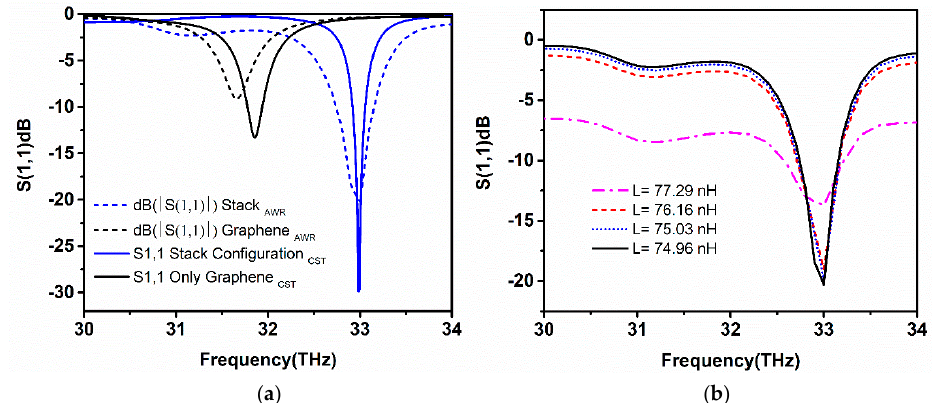
Figure 18. ( a ) Comparison of equivalent circuit model and CST results; and, ( b ) Inductance tuning resonance response of the equivalent circuit model.